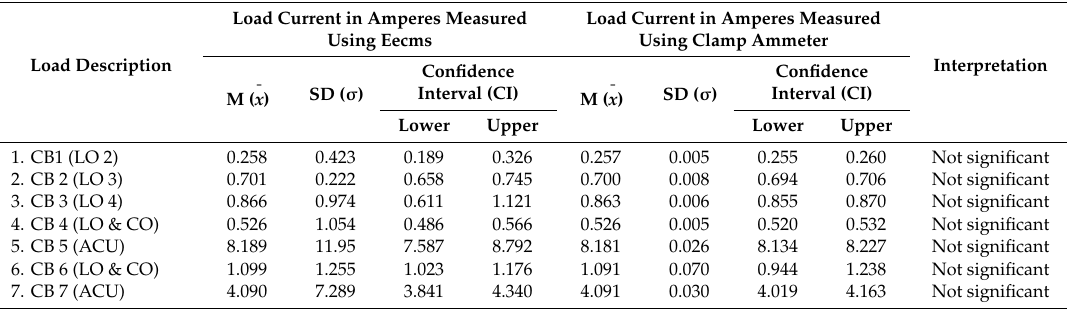
Table 6. A descriptive statistical representation of the electric current using the proposed EECMS device and commercial clamp ammeter (note: the sensor is connected directly to the supply side of the circuit breaker in the primary circuit